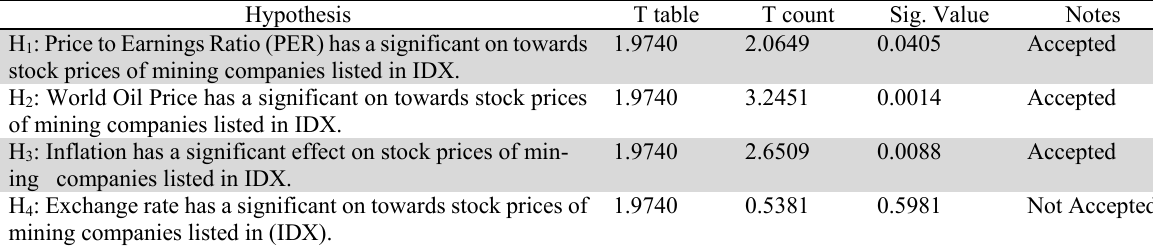
Hypothesis Test of Partial Test (T-Test) Result